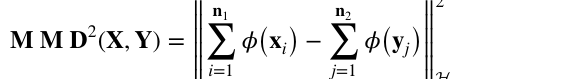
Fig. 2 Effect of word vector dimension on model